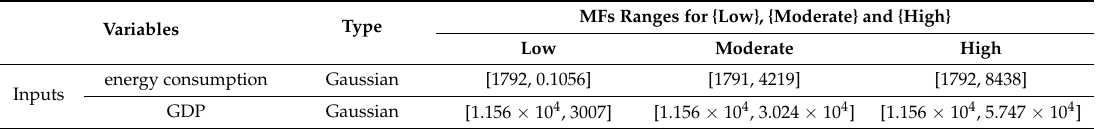
Table 1. Membership functions (MFs) information for the first cluster in predicting CO 2 for the United States. GDP: gross domestic product.